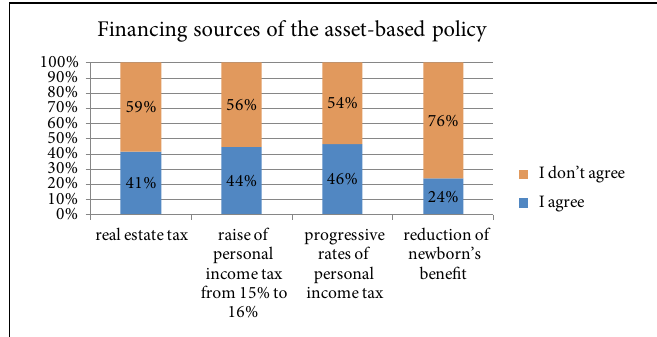
Fig. 15. Respondents’ opinion towards the financing sources of the asset-based policy (authorial computation, according to the survey data)